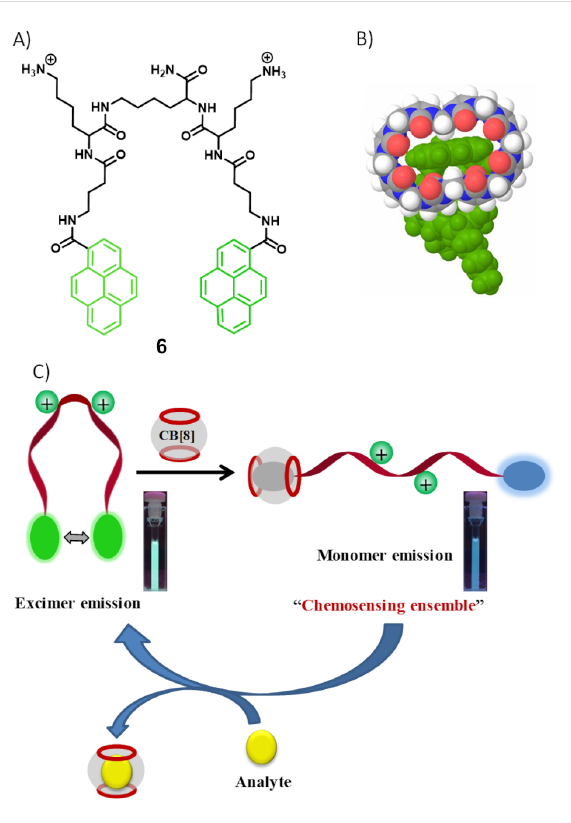
Figure 6: A) Molecular structure of 6 ; B) possible binding mode of pyrene termini of 6 to CB[8] according to molecular